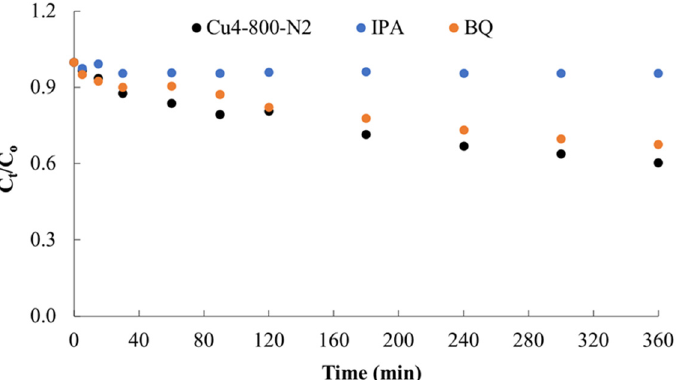
Figure 11. Concentration decay curves of Y5 photodegradation on sample Cu4-800-N 2 in the absence and presence of IPA and BQ hydroxyl radical (•OH) and superoxide radical (•O2–) chemical scavengers. Initial concentration, 5 ppm of Y5 dye.